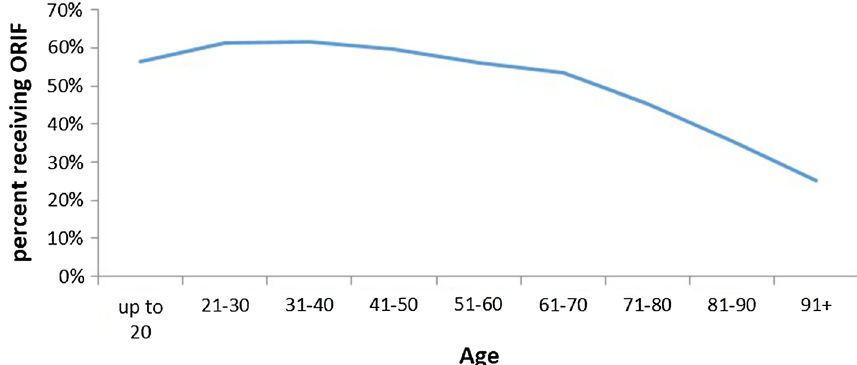
Fig. 3 Utilization of operative intervention for humeral shaft fractures by